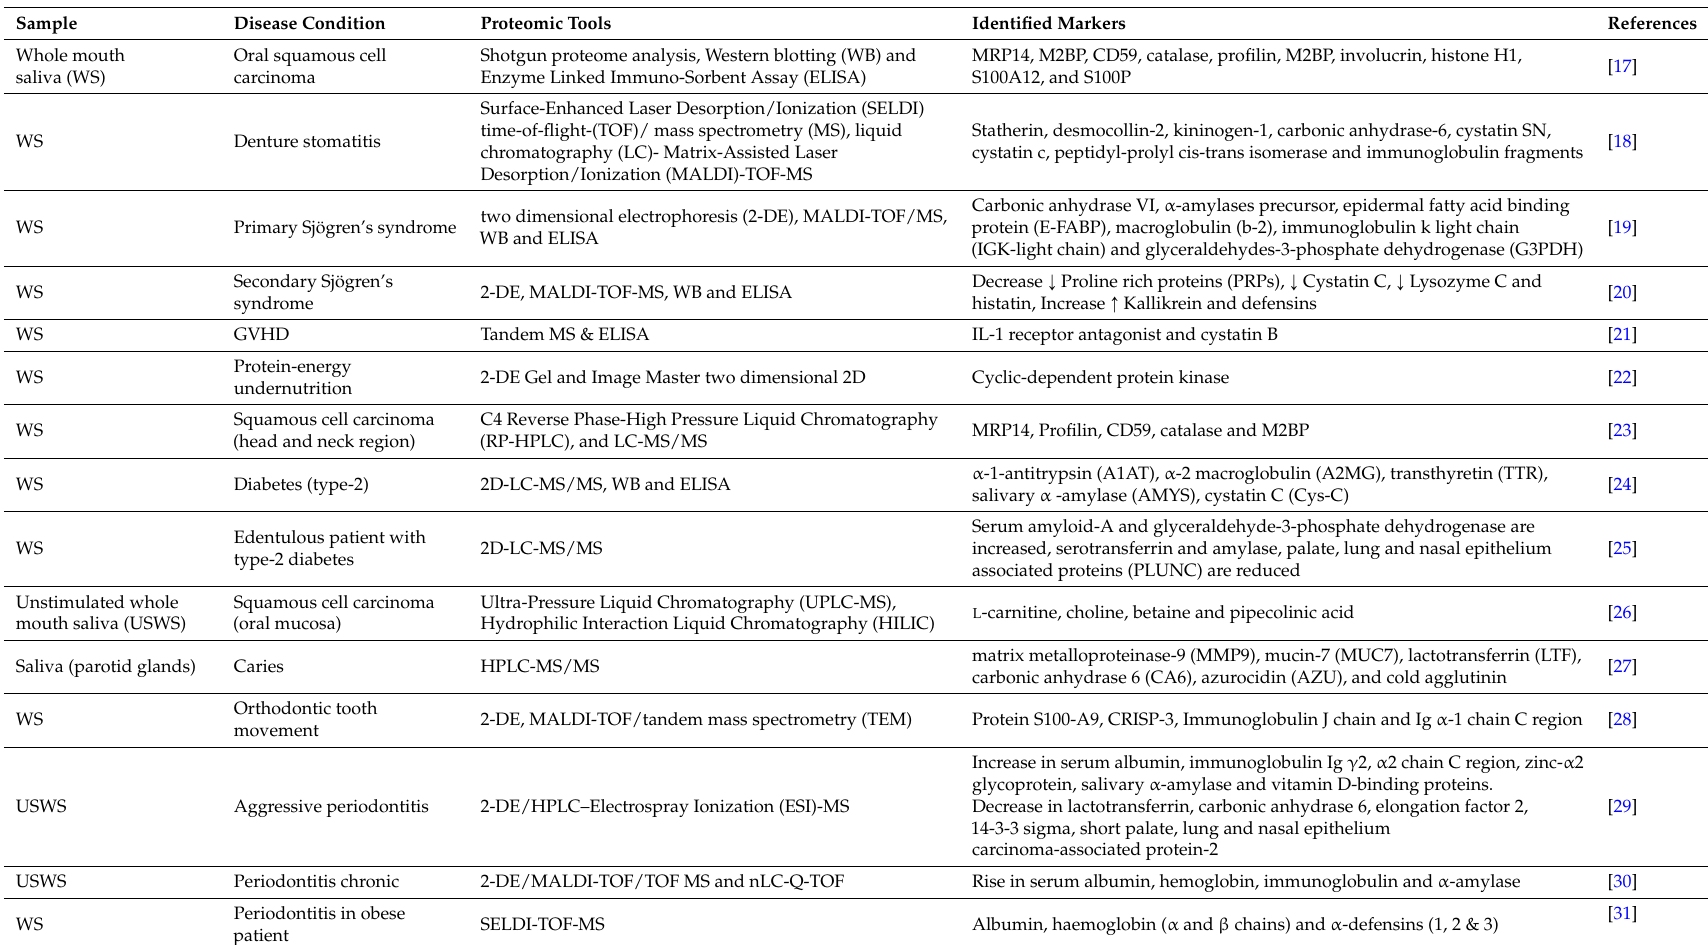
Table 1. Detailed discussion of oral diseases protein analysis using proteomic